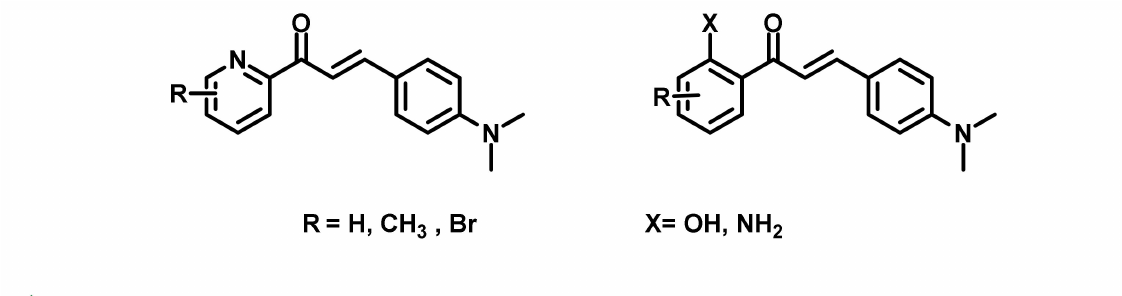
Figure 7. Chalcone derivatives with simple substitutions by Fosso et al. [41].